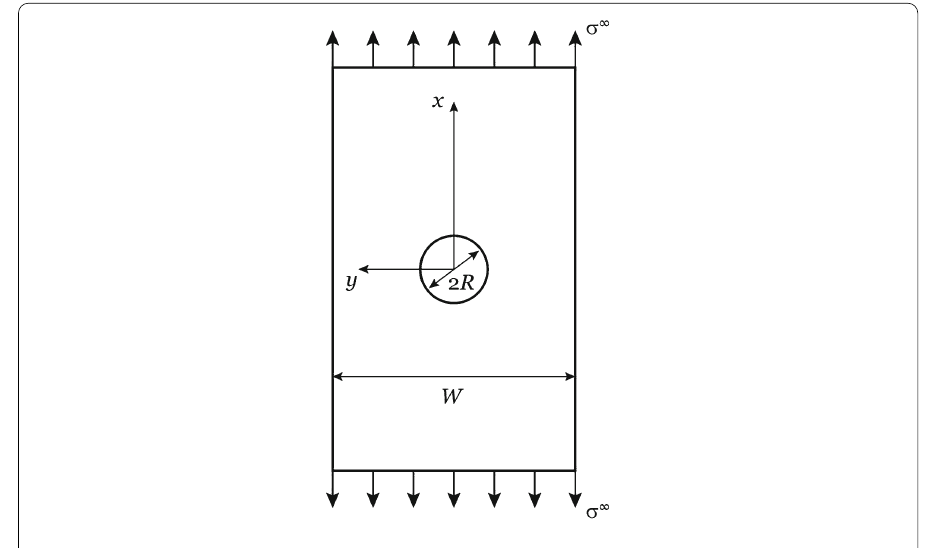
Fig. 4 Geometry of the simulated open-hole lamina (from [51]) Fracture in 3D solid